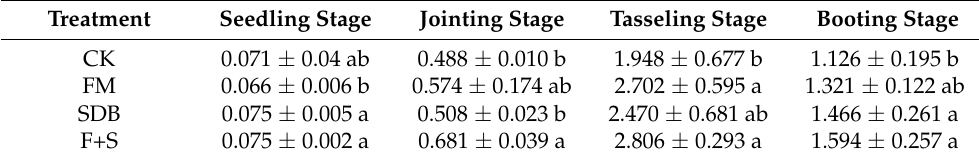
Table 7. The leaf area indexes under each treatments unit: (cm 2 /cm 2 ).